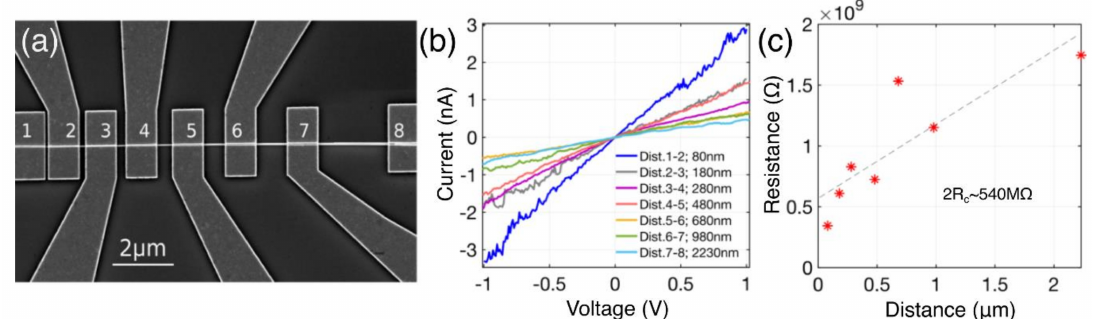
Figure 6. ( a ) SEM image of CuO nanowire with 8 electrodes of distances from 80–2380 nm; ( b ) current— voltage characteristics measured at room conditions and in 2-probe configuration; ( c ) resistance as a function of the nanowire length (di ff erent distance between the electrodes). Linear fit (dashed line) intercepts with the y axis at around 540 M Ω representing the contact resistance of the two electrodes 2Rc. SEM image and all the data shown here were recorded for CuO nanowire grown in dry air, without electrical field, nanowire